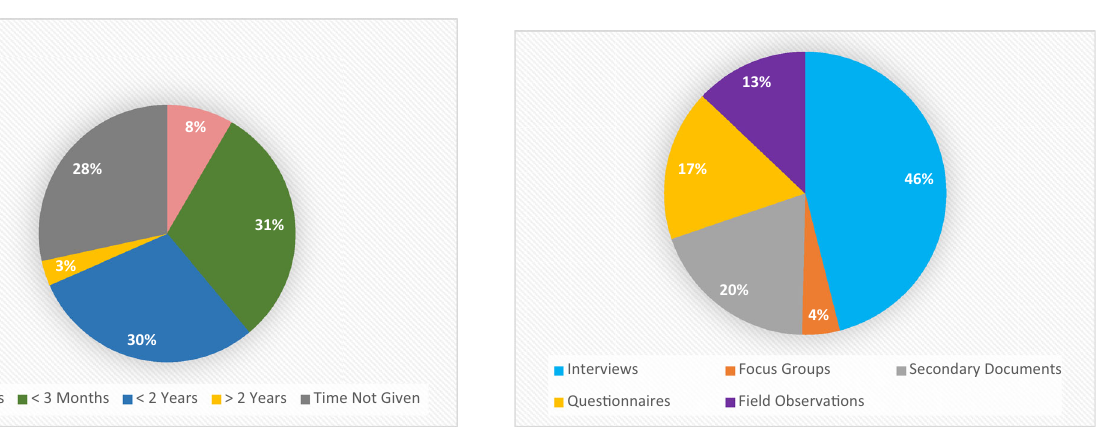
Fig. 3 Proportion of studies by data collection timing Fig. 4 Proportion of studies by research